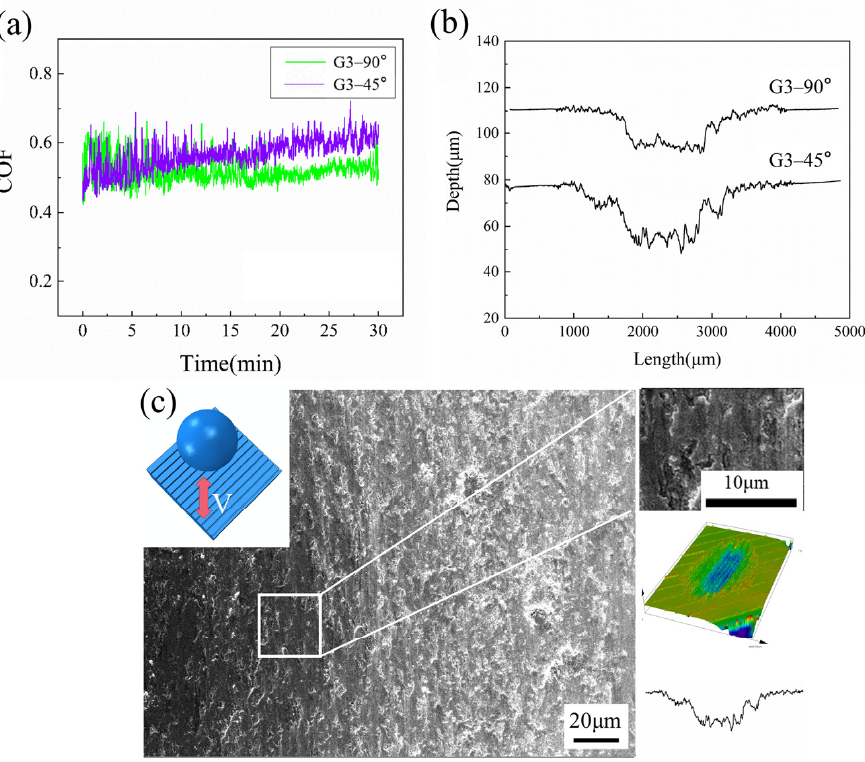
Figure 14. The ( a ) COF, ( b ) wear section and area; ( c ) SEM and LCM morphologies of G3 in the 45° and 90° friction directions when sliding with TC4.